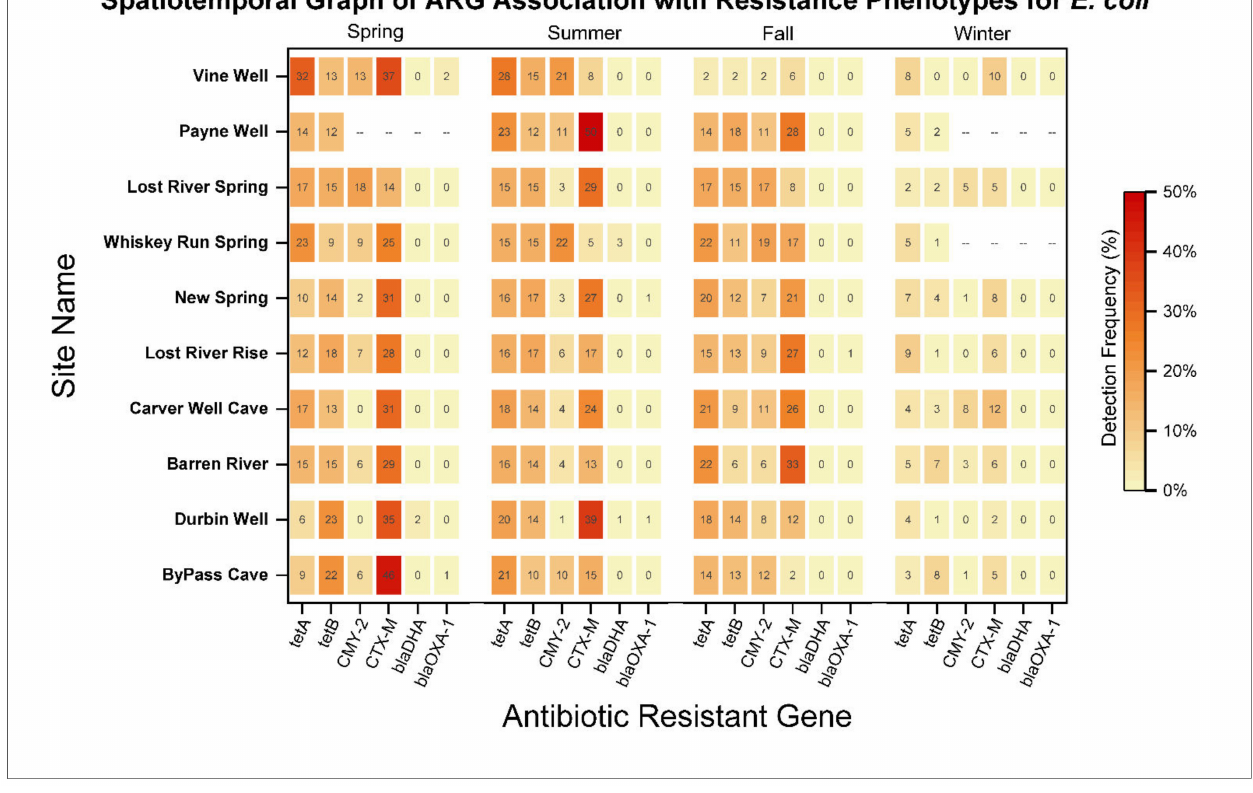
Figure 12. Spatiotemporal trends of ARGs associated with resistance phenotypes for E. coli